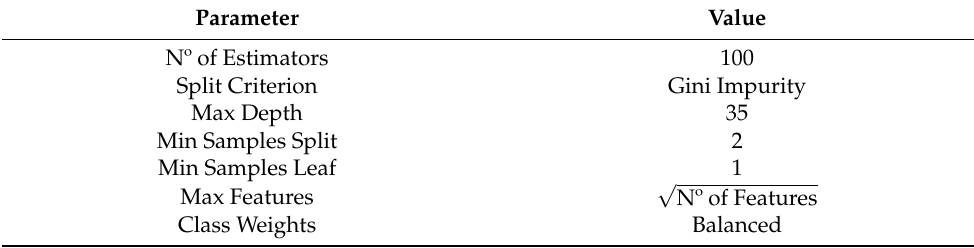
Table 4. Summary of Random Forest